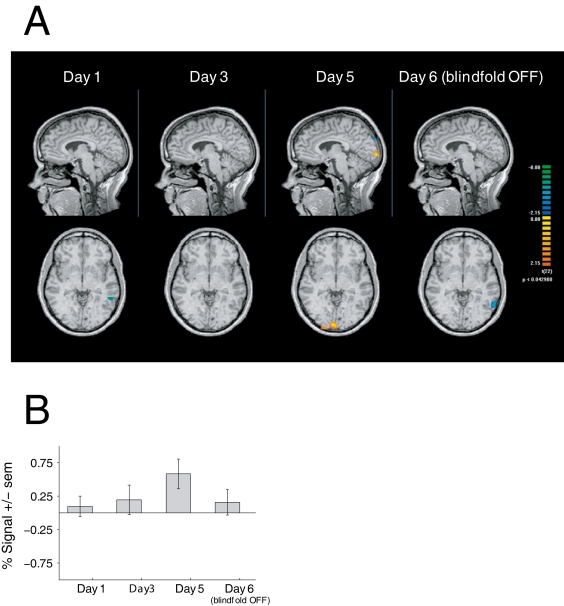
Neuroimaging results.(a) Differential tactile activation maps contrasting the blindfold and non blindfold groups are shown for each fMRI session of the study. (b) A region of interest (ROI) was defined by the area of occipital activation found on day 5 in the group maps. The average differential tactile activity between groups in this ROI is plotted here in z-score units across days of the study. The difference between groups was significant on day 5, as expected from the definition of the ROI, but did not reach significance on any other day.